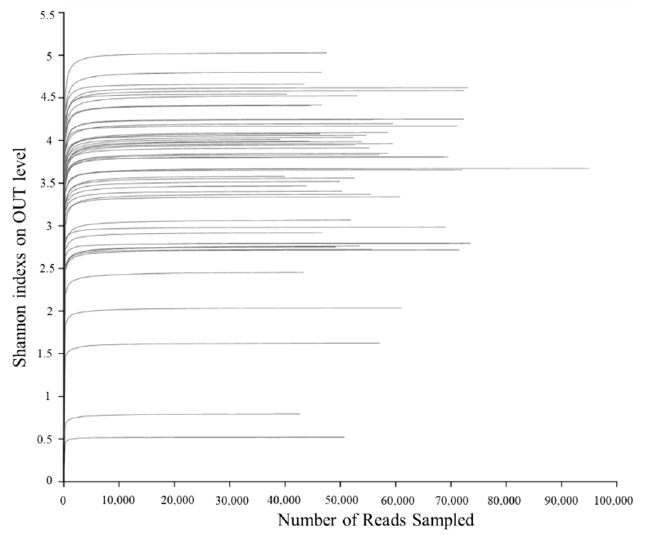
Figure 2. Shannon dilution curves of different samples. Table 2. Table of soil fungal diversity indicators under different farmland consolidation.